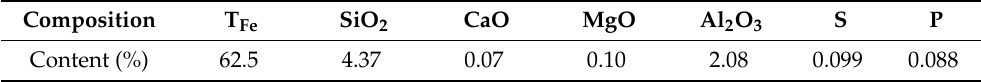
Table 1. Chemical composition of the Australian Newman mineral powder (mass %).